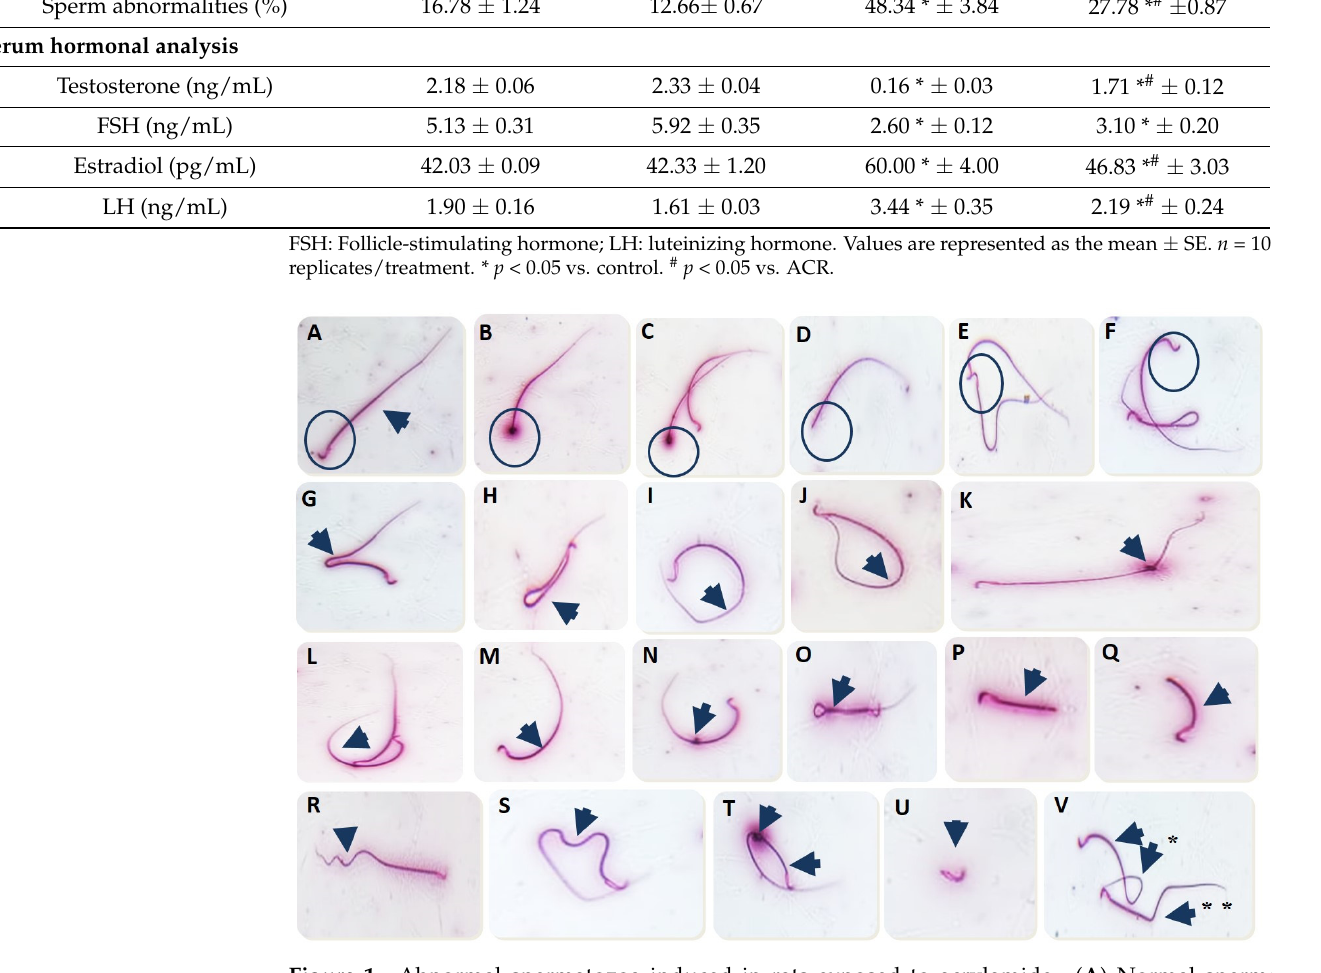
Figure 1. Abnormal spermatozoa induced in rats exposed to acrylamide. ( A ) Normal sperm; ( B , C ) Amorphous head; ( D ) Detached head; ( E ) Fused heads; ( F ) Bent head; ( G , H ) Bent tail; ( I , J ) Looped tail; ( K ) Protoplasmic droplet; ( L , M ) Curved tail; ( N ) Curved tail with protoplasmic droplet; ( O ) Coiled tail; ( P ) Short tail; ( Q ) Short curved tail; ( R , S ) Curled tail; ( T ) Looped tail with protoplasmic droplet; ( U ) Detached tail; ( V ) * Curved looped tail; (V) ** Broken tail.